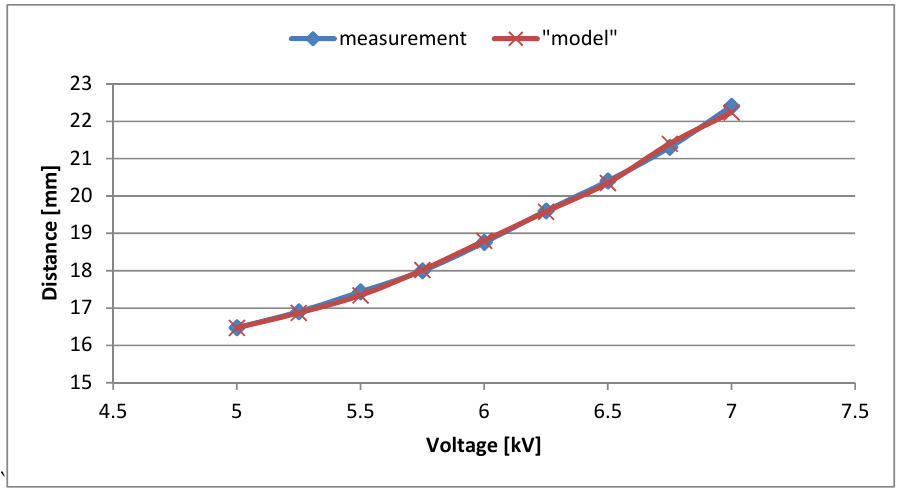
Figure 6. Comparison of membrane distances for static load force 1.23 [N].